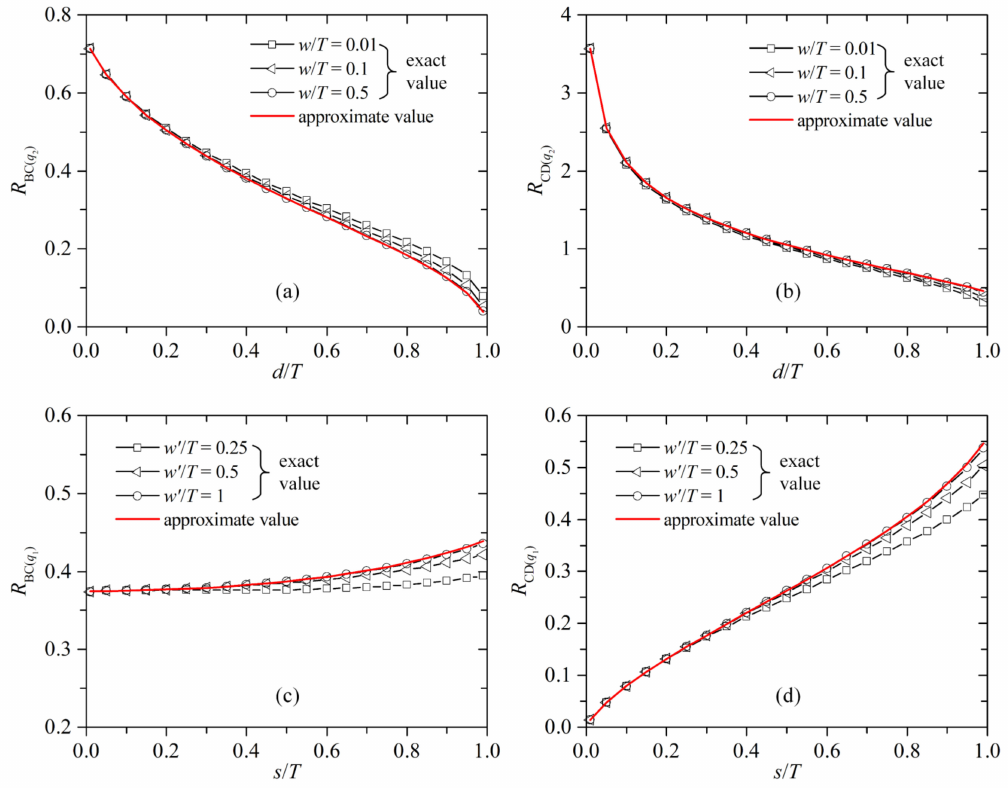
Figure 6. Calculation results of the four normalized average drawdowns: ( a ) R BC( q ( c ) R BC( q , and ( d ) R CD( q 1 )